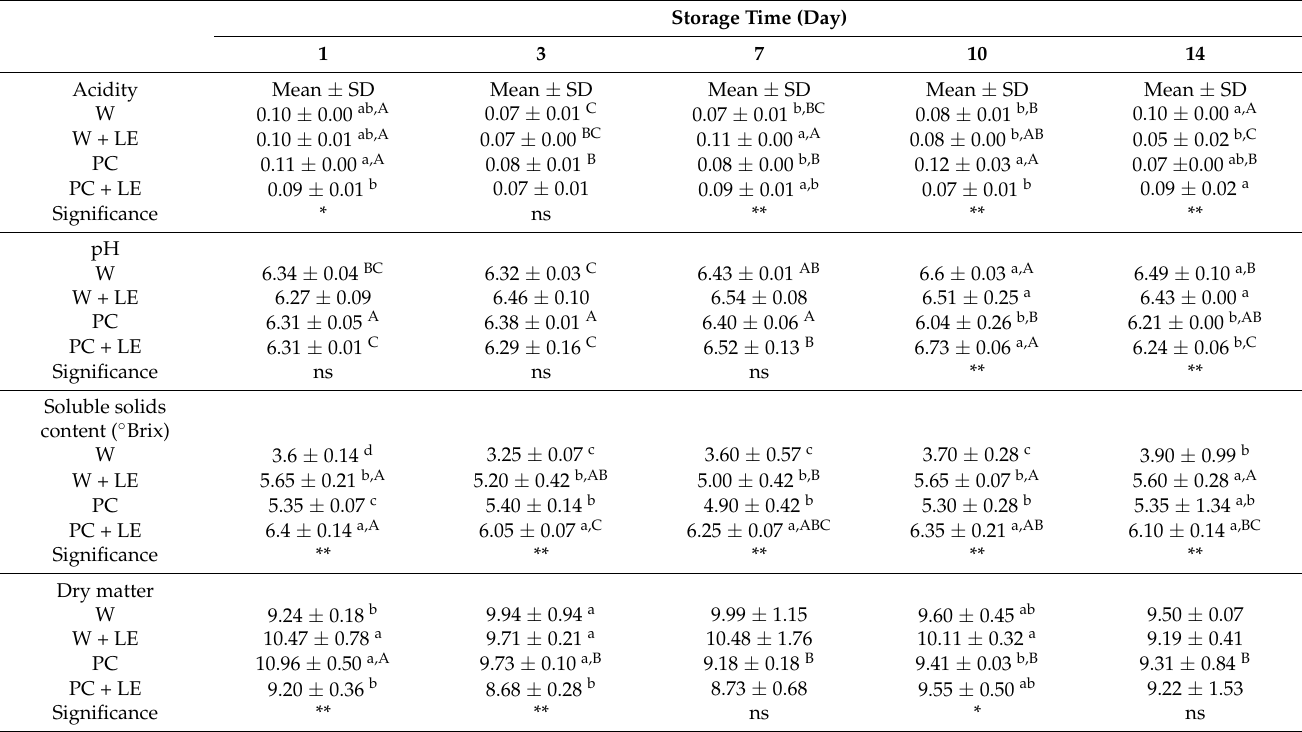
Table 1. Changes in acidity, pH, total soluble solids (Brix ◦ ) and dry matter of uncoated and coated fresh-cut carrots during 14 days of storage (4 ◦